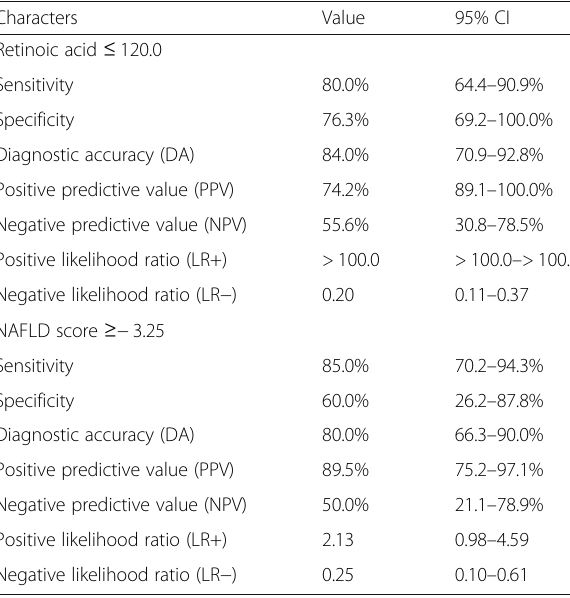
Table 3 Correlation between retinoic acid and other variables among the studied groups Variables